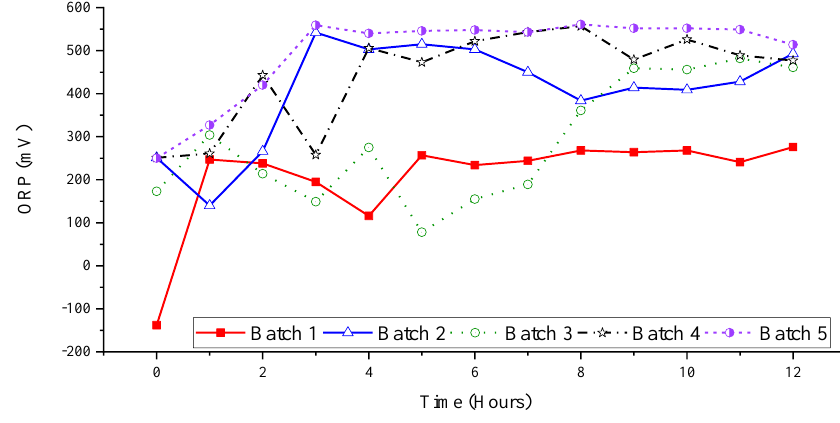
Figure 2. Effect of ozone and perozone on ORP of groundwater over time.